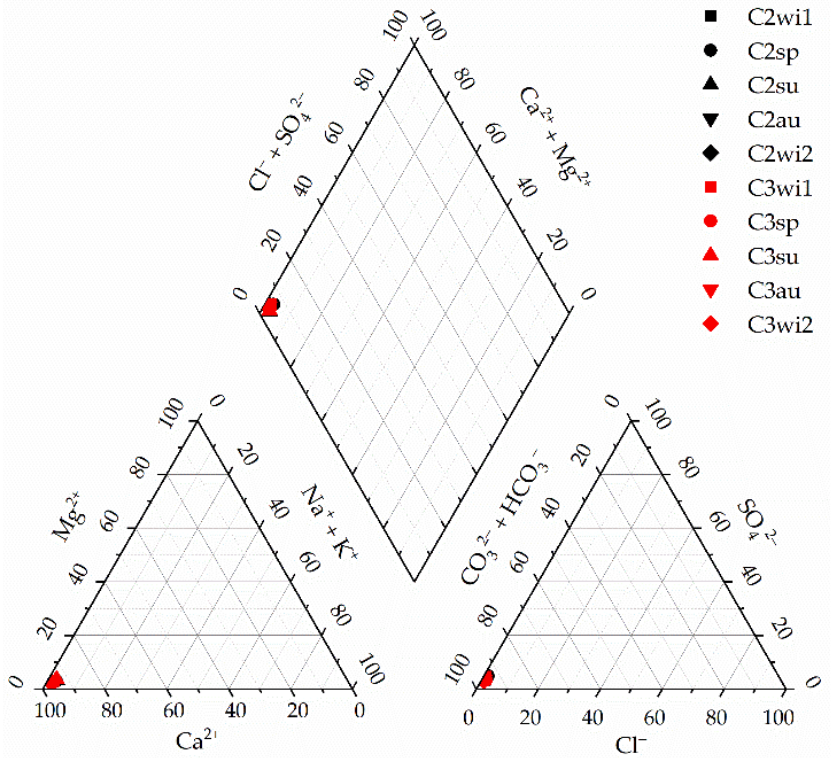
Figure 1. Piper trilinear diagram for the water samples collected from Clo ș ani Cave. C2—water samples collected from a small pool on the clayish floor; C3—water samples collected from a small pond on calcite. wi—winter; sp—spring; su—summer; au—autumn. The Gibbs diagram [16] for the cations (TDS vs. Na + /Na + + Ca 2+ ) and anions (TDS vs. Cl − /Cl − + HCO 3 − ) for the water samples collected from Clos Figure